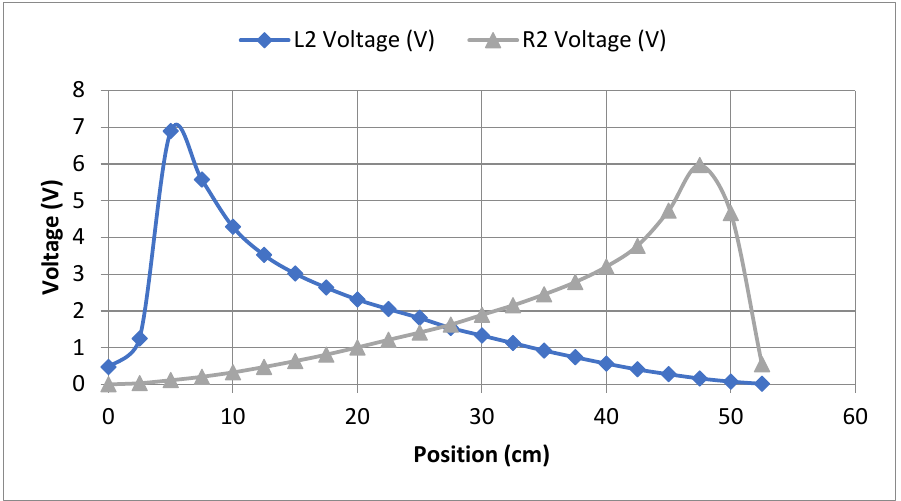
Figure 7. L2 and R2 sensors’ voltage reading in term of load position.